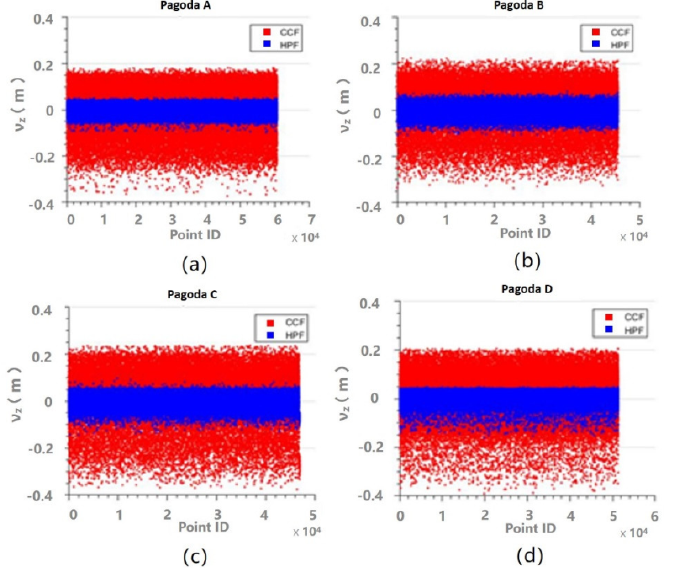
Figure 9. Residuals of z for the CCF (red) and the HPF (blue) for Part 1: ( a ) Pagoda A; ( b ) Pagoda B; ( c ) Pagoda C; and ( d ) Pagoda D.